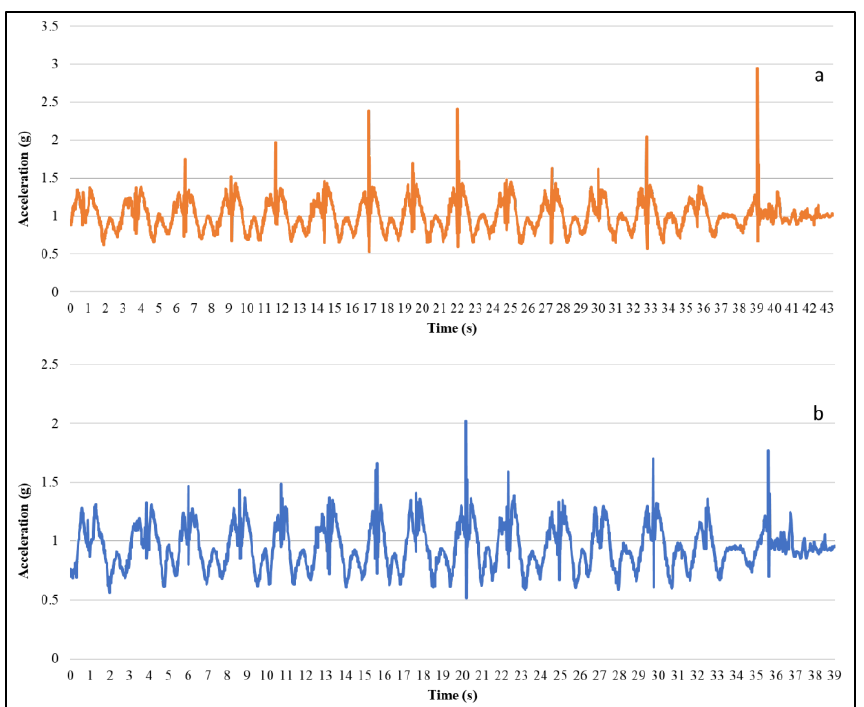
Figure 5 . Acceleration magnitude while lifting using ( a ) conventional sensor and ( b ) armband sensor.